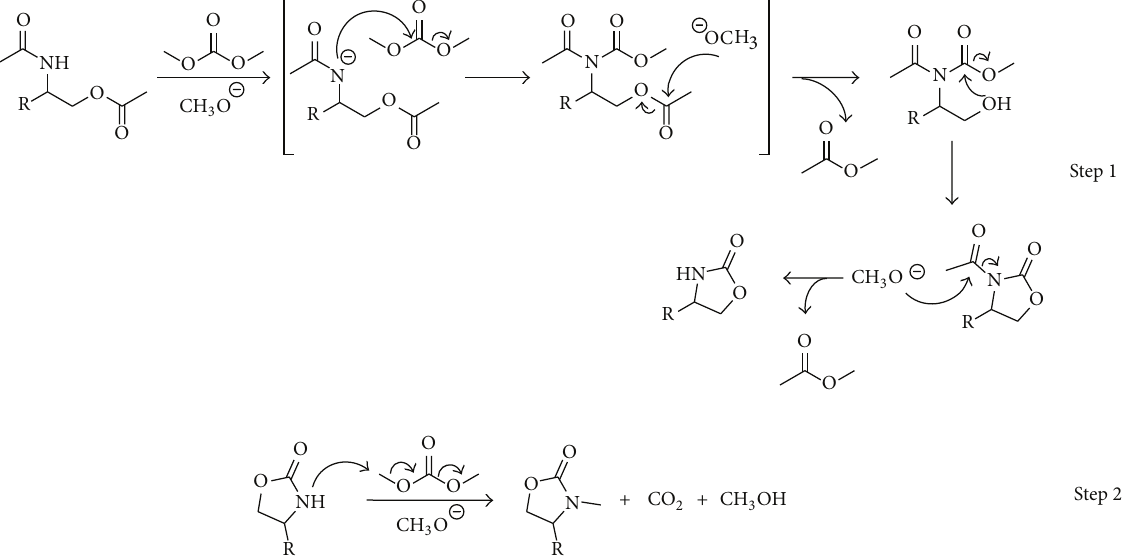
Scheme 9: Plausible mechanism for the cyclization of adiacetylated aminoalcohol using TBAC and